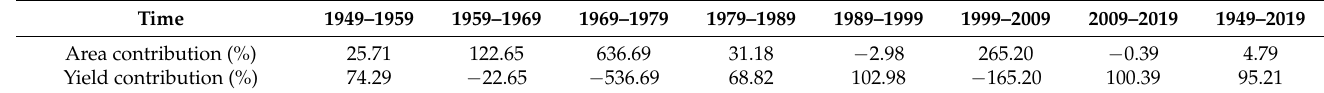
Table 3. Contributions of soybean sown area and yield to soybean production from 1949 to